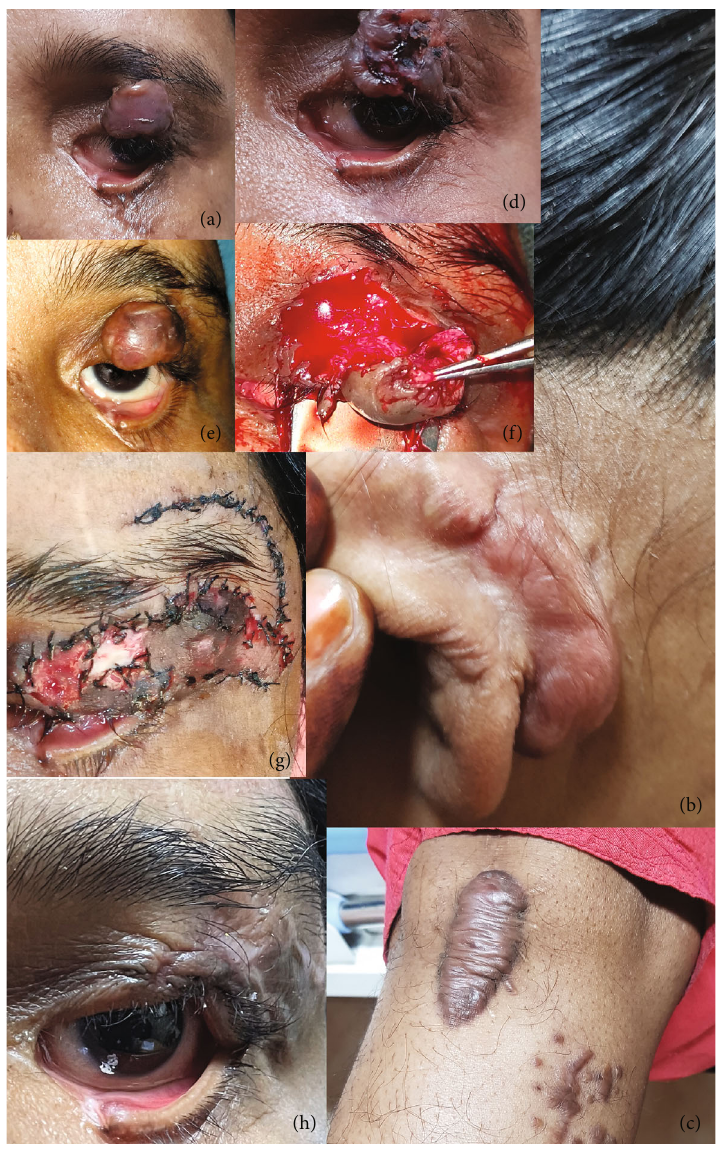
Figure 1: (a) A well-de fi ned mass seen on the left upper lid ( 1 : 5 cm × 1 : 2cm × 1cm ) involving the lid margin. (b) Thickened mass seen in the postauricular area. (c) Hyperpigmented lesions seen on the right leg. (d) Ulceration of keloid surface following intralesional 5-FU (50 mg/mL) and crystalline TAC (40 mg/mL) injection. (e) Regrowth of keloid after discontinuation of 5-FU (50 mg/mL) and crystalline TAC (40 mg/mL) injection. (f) Excision of keloid. (g) Development of postsurgical wound infection. (h) Clinical appearance after 16 months of upper lid keloid